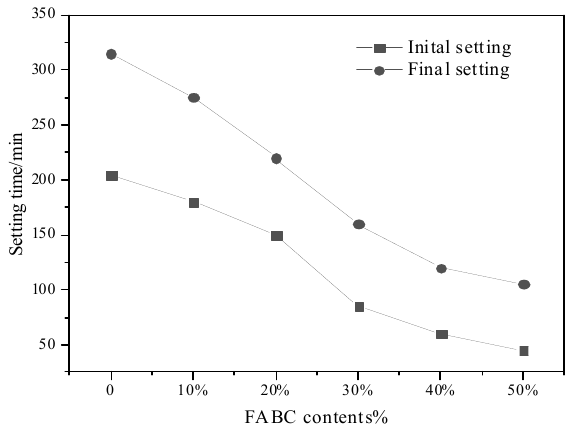
Figure 1. Setting time of cement with different FABC content.